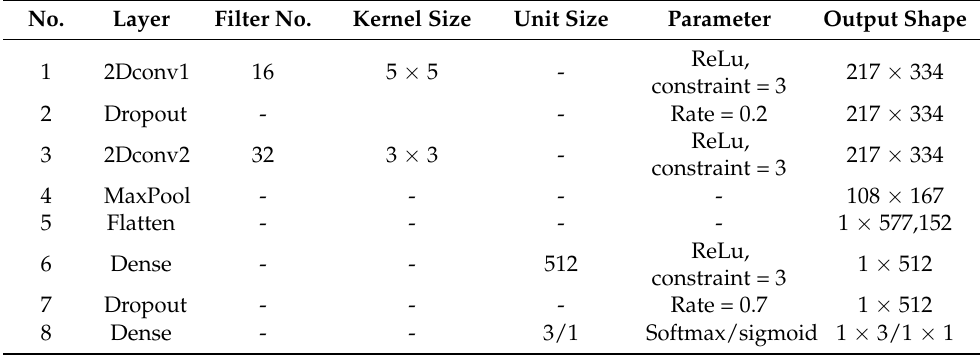
Table 4. Complete details of layer parameters of proposed 2D-CNN model.